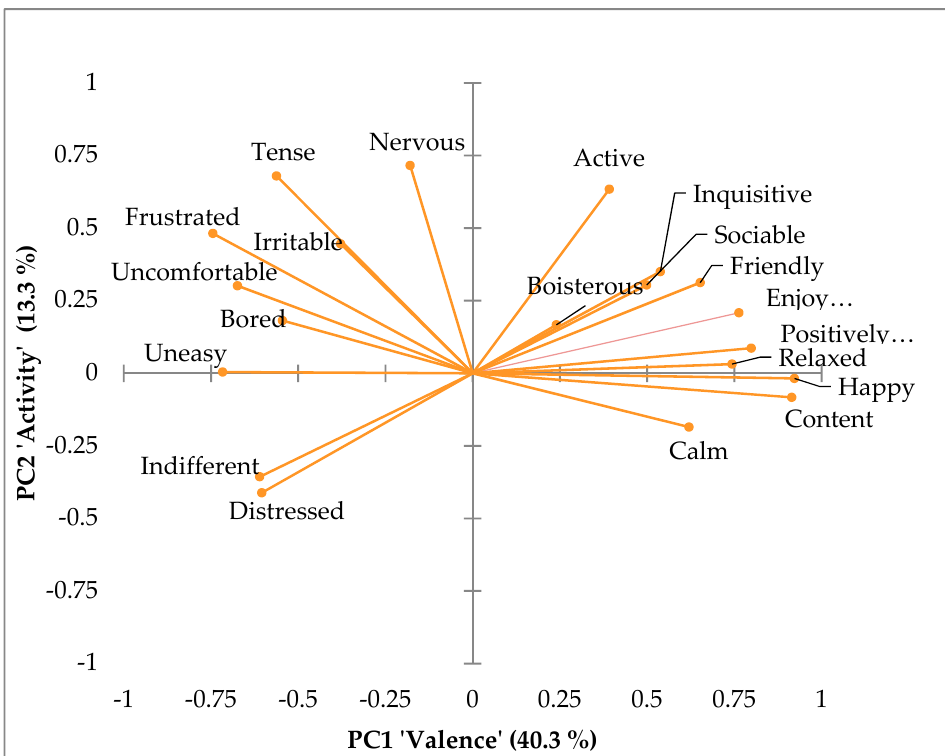
Figure 1. Two-dimensional loading plot of the Principal Component Analysis (PCA) results showing the distribution of all 20 terms describing the quality of calf behavior on PC1 (Valence) and PC2 (Arousal) as vectors.